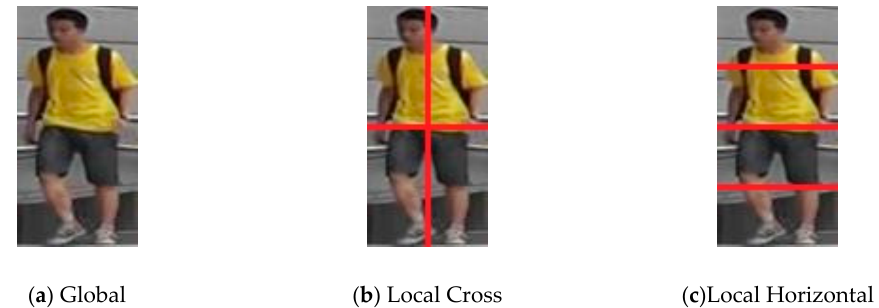
Figure 4. Region segmentation. The size of the Global part is 128 × 64. The size of the sub-blocks of Local Cross and Local Horizontal are 64 × 32 and 32 × 64, respectively.